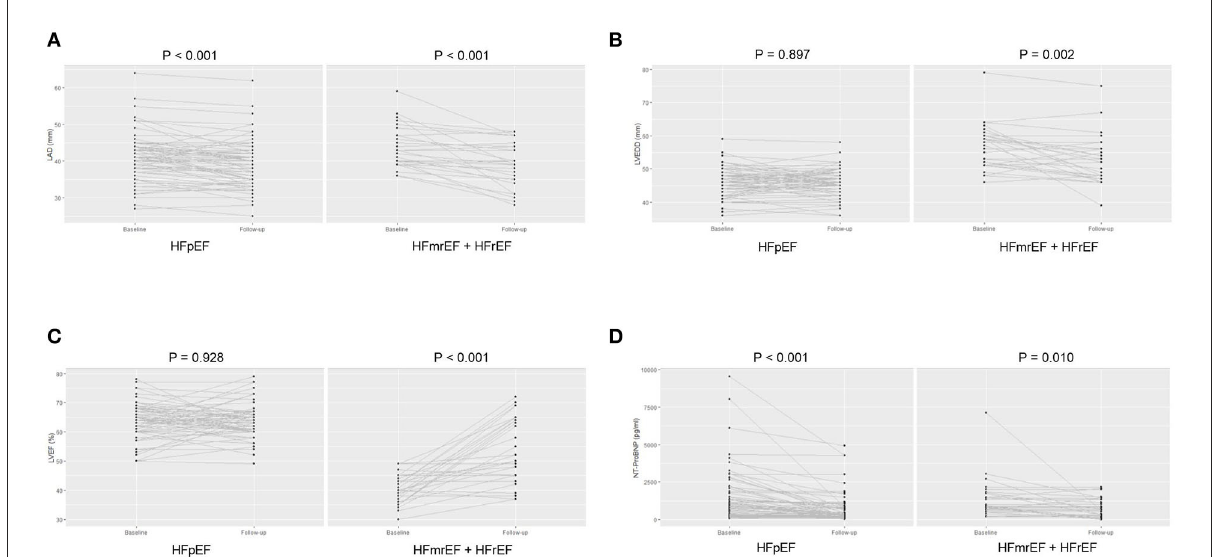
FIGURE5 The left atrial diameter (A) , left ventricular end-diastolic diameter (B) , and left ventricular ejection fraction (C) , N-terminal pro-B type natriuretic peptide level (D) of patients at baseline and the end of follow-up in heart failure with preserved ejection fraction and heart failure with mid-ranged ejection fraction + heart failure with reduced ejection fraction groups. LAD, left atrial diameter; LVEDD, left ventricular end-diastolic diameter; LVEF, left ventricular ejection fraction; NT-ProBNP, N-terminal pro-B type natriuretic peptide; HFpEF, heart failure with preserved ejection fraction; HFmrEF, heart failure with mid-range ejection fraction + heart failure; HFrEF, heart failure with reduced ejection